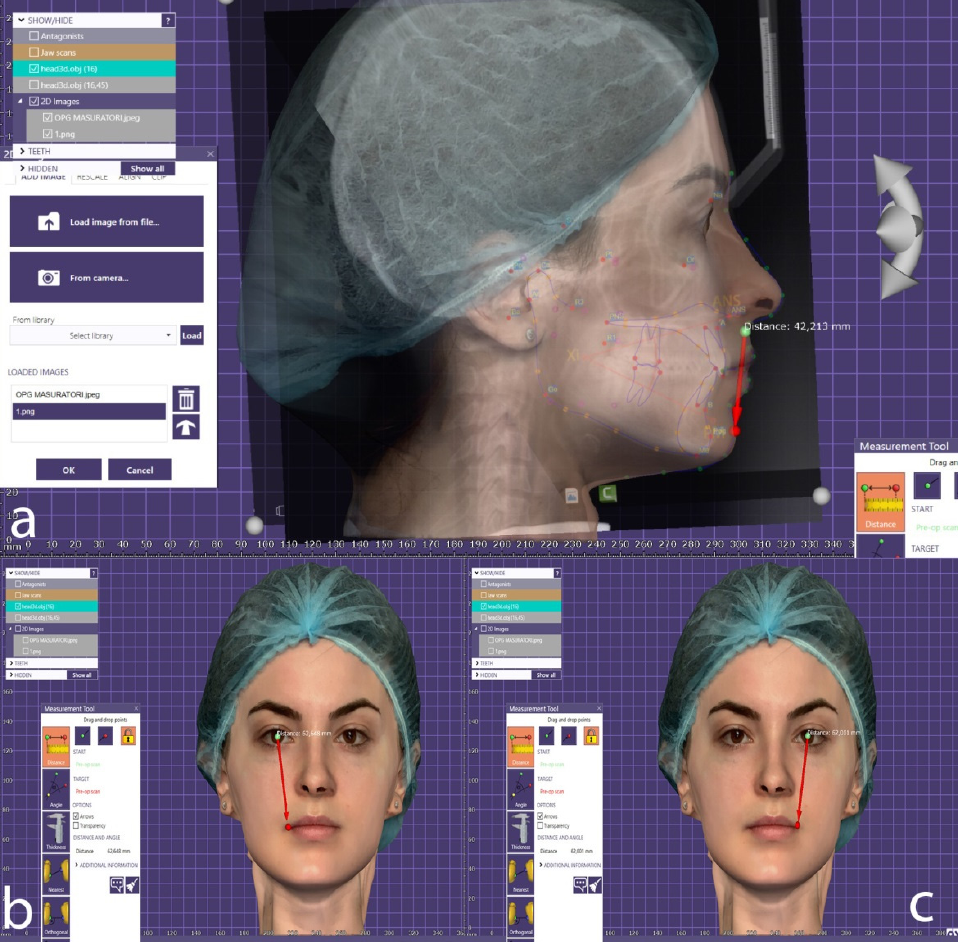
Figure 4. Digital anthropometric measurements on facial scans in maximum intercuspation position: